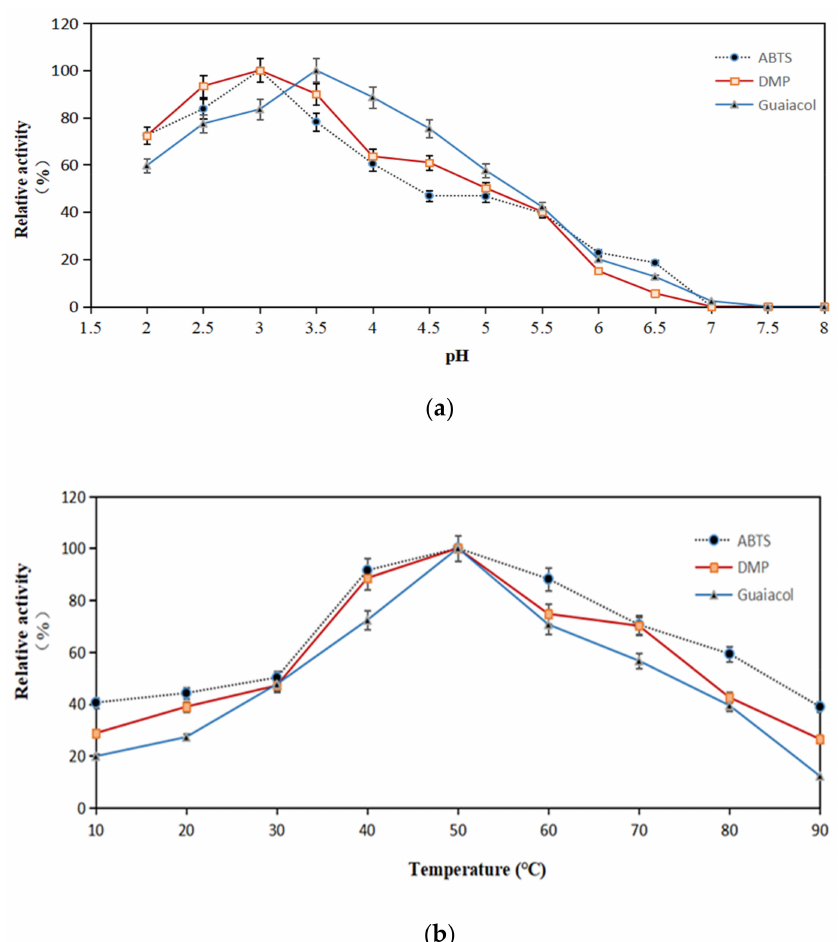
Figure 4. The optimum pH ( a ) and temperature ( b ) of X33-Lac-2. The e ff ect of pH on the laccase activity was measured in citrate-phosphate bu ff er (pH 2.0–8.0) at 25 ◦ C. The activity of 100% was that which was measured at the optimal pH. The e ff ect of temperature on the laccase activity was measured at the optimal pH from 10 ◦ C to 90 ◦ C. The activity of 100% was that which was measured at the optimal temperature. Each point represents the mean ± SD ( n =